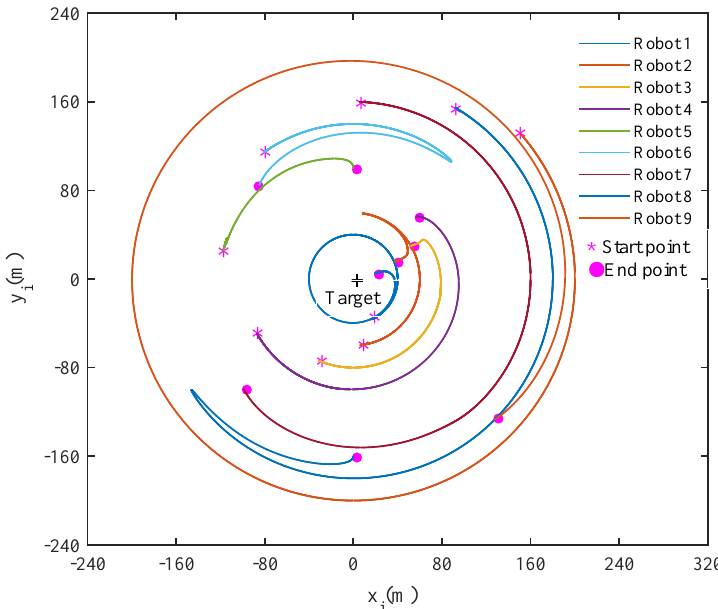
Figure 6. Trajectories of nine robots on the plane at t ∈ ( 0,10 ] when k r = 1 and k θ = 1.